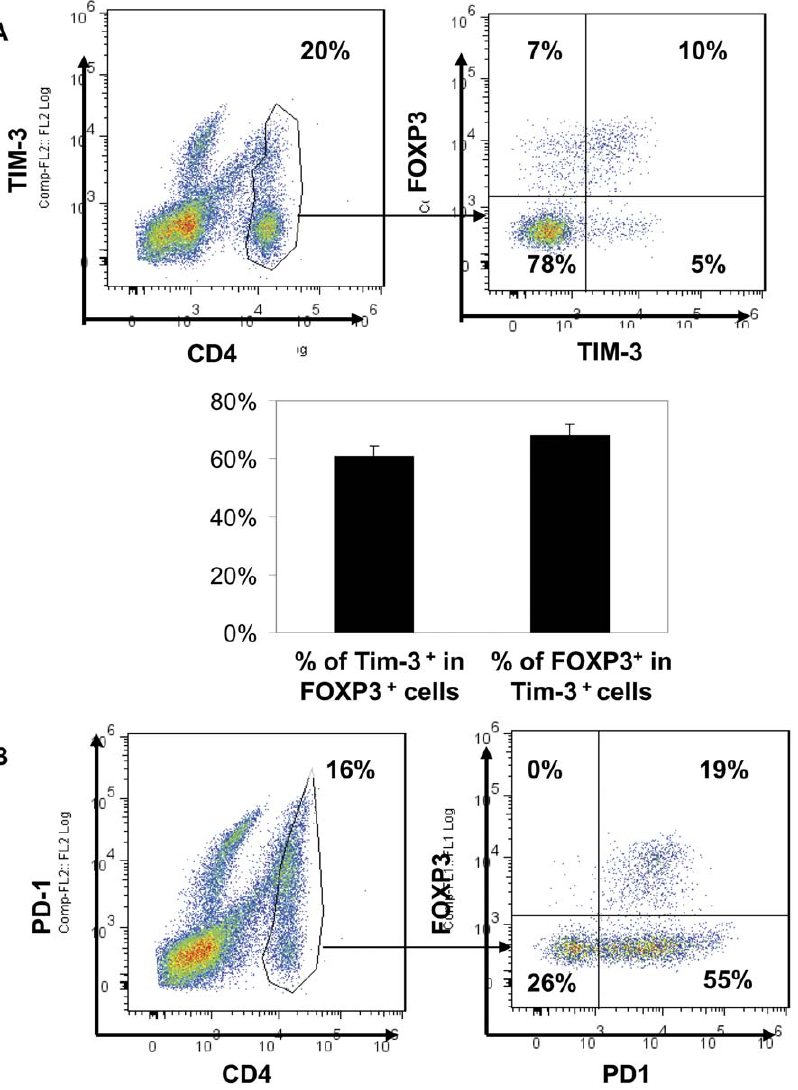
Figure 3. TIM-3 expression on CD4 + TILs and Treg. TILs were harvested from lung cancer tissue. Cells were then stained for CD4, TIM-3, and FOXP3 (A) or CD4, PD-1, and FOXP3 (B). Lymphocytes were gated for further analysis of CD4 and CD8 T cells. The percentage of each population within CD4 + T cell compartment was indicated. Data shown are representative of five independent experiments.